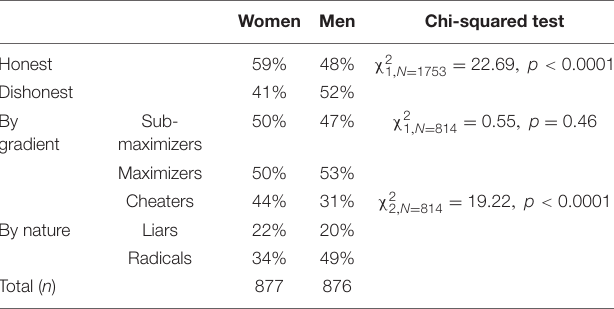
TABLE 2 | Proportion of men and women with different (dis)honesty profiles. Women